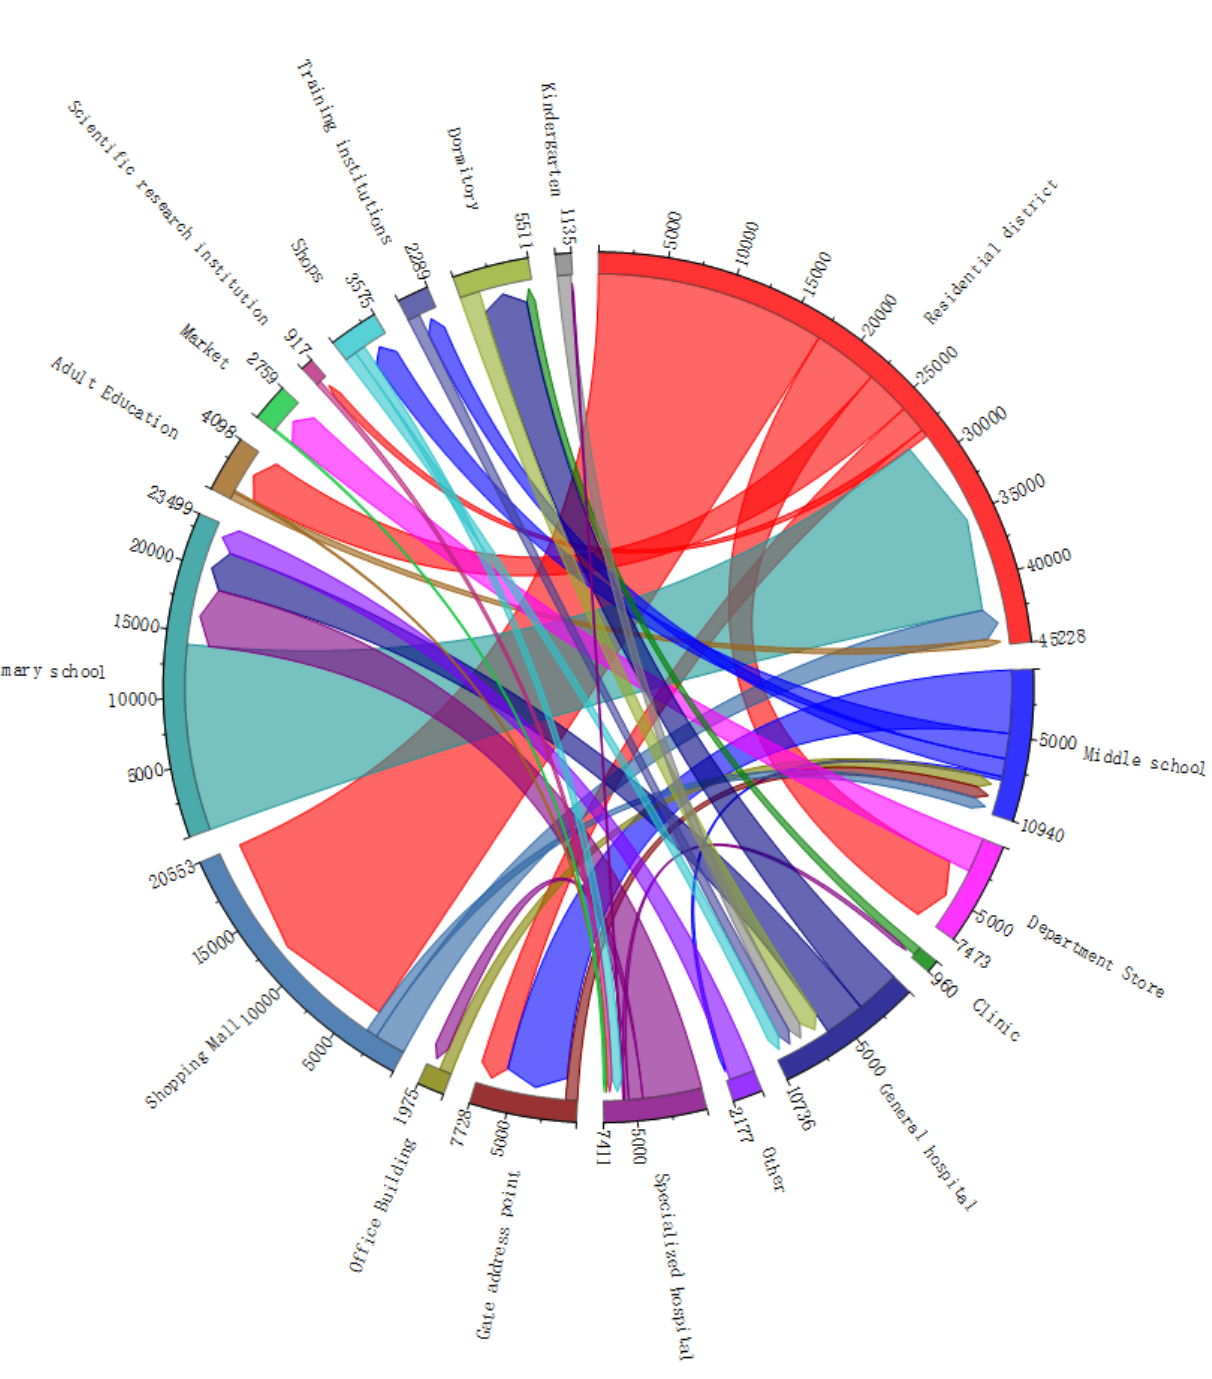
Figure 7. Traffic flow of adjacent functional areas in the city.